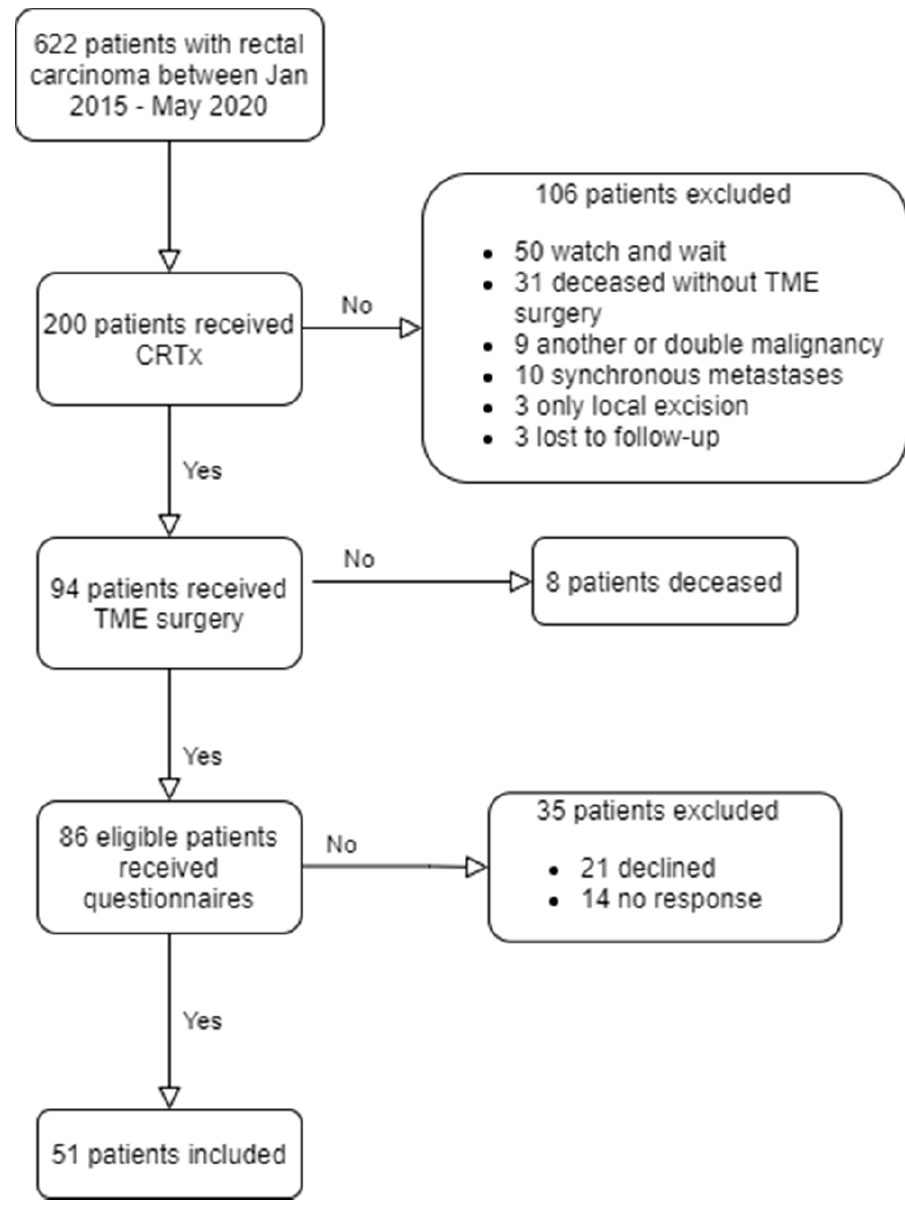
Figure 1. Inclusion strategy. Table 1. Patient demographics immediate vs. delayed surgery groups. p -values in bold are signifi- cant (<0.05).